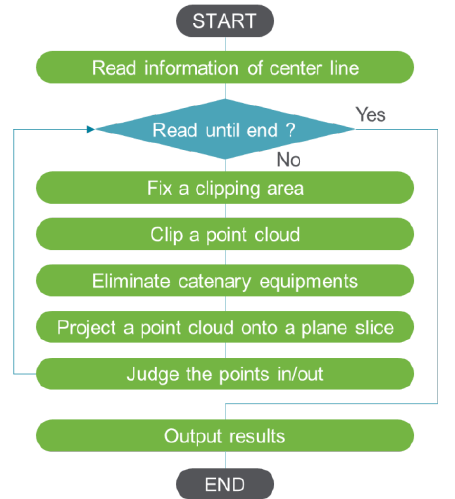
Figure 5. The overall algorithm of the clearance check